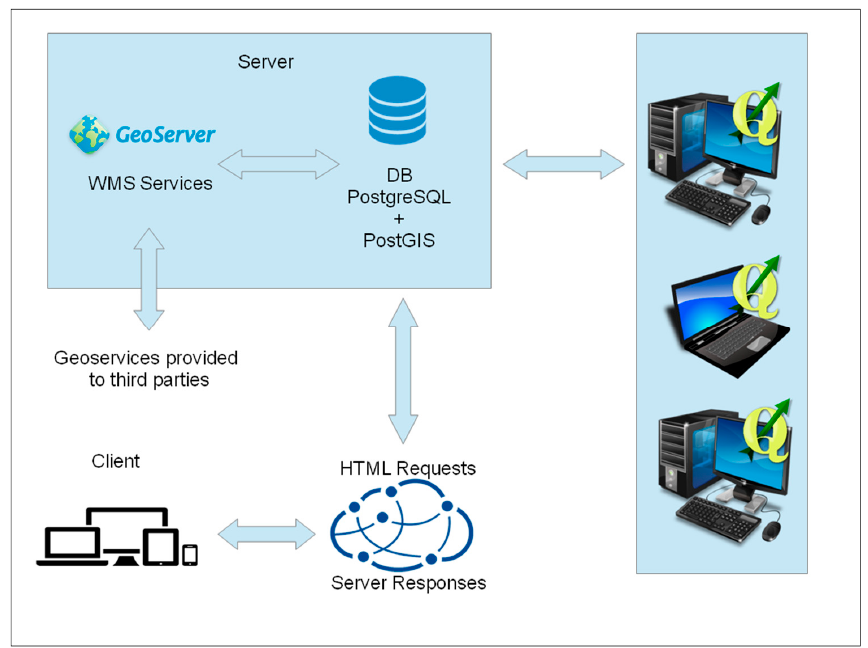
Figure 1. Spatial Information System Infrastructure.